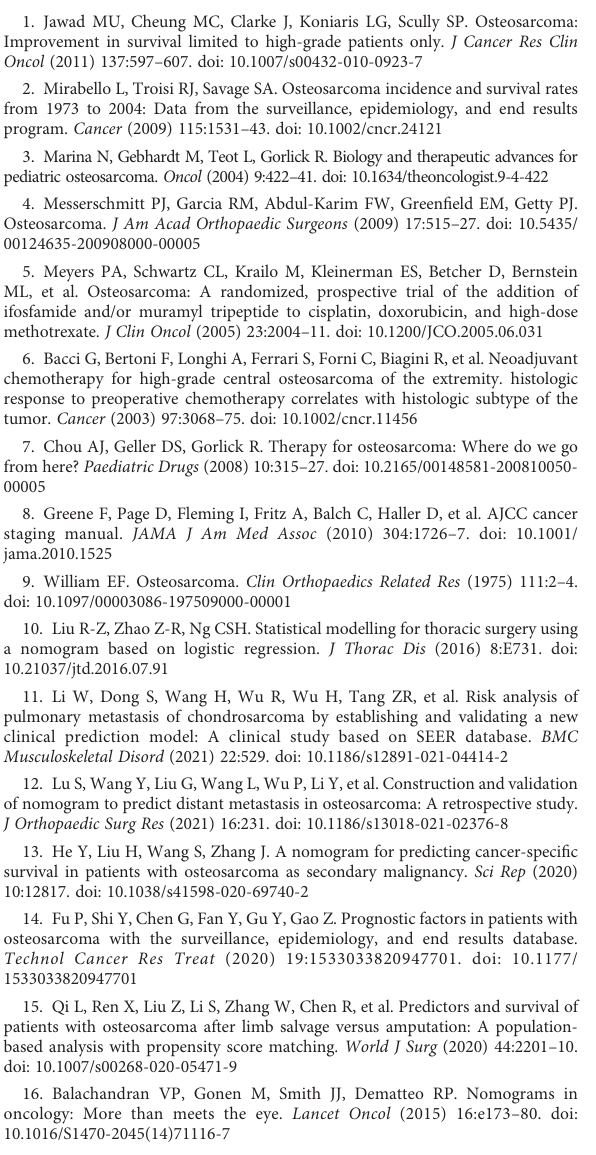
Bone metastases. (D) grade. (E) Laterality. (F) Lung metastases. (G) M. (H) surgery. i tumor size. SUPPLEMENTARY FIGURE 3 External ROC curve in 1 year, 3 years, 5